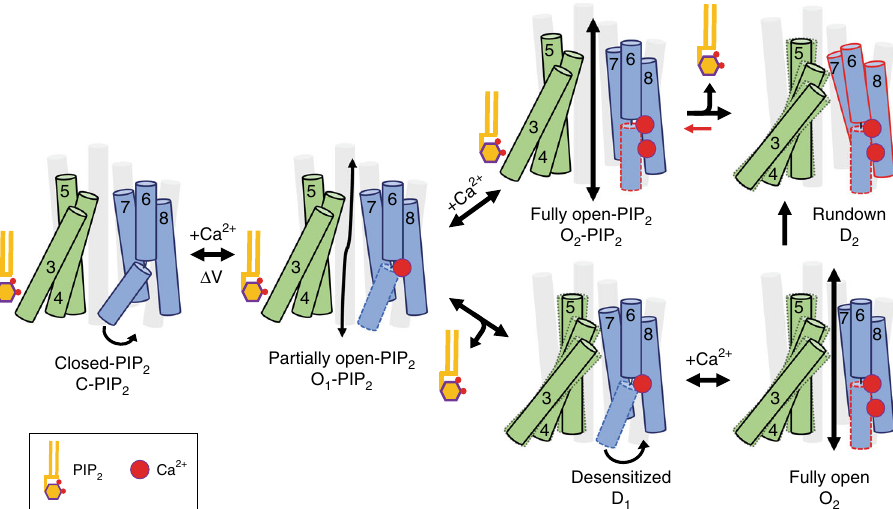
Fig. 7 Proposed mechanistic model of PIP 2 -dependent modulation of TMEM16A gating. The ion permeation pore is formed by two distinct structural modules that bind to PIP 2 (TMs 3 – 5, green) and Ca 2 + (TMs 6 – 8, blue), respectively. The remaining TMs (1, 2, 9, and 10) are shown in light gray. Ca 2 + binding to the Ca 2 + module of a closed channel (C-PIP 2 ) opens the ion permeation pore, whereas PIP 2 binding to the regulatory module stabilizes this open conformation (O 1 -PIP 2 ). Depletion of PIP 2 from the O 1 -PIP 2 state reversibly desensitizes the channel (D 1 ), which can be opened by higher Ca 2 + (O 2 ). Prolonged channel opening under saturating Ca 2 + (O 2 -PIP 2 ) induces both PIP 2 dissociation from the regulatory module that subsequently results in an energetically stable closed state (D 2 ) that is resistant to reactivation by exogenous PIP